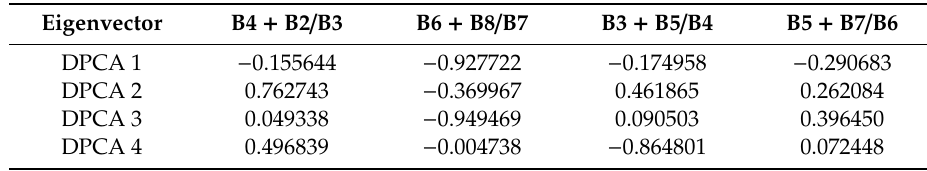
Table 5. Eigenvector matrix of the WV-3 band ratio indices derived from the DPCA for the selected subset covering the southern part of Cu-Au mineralization